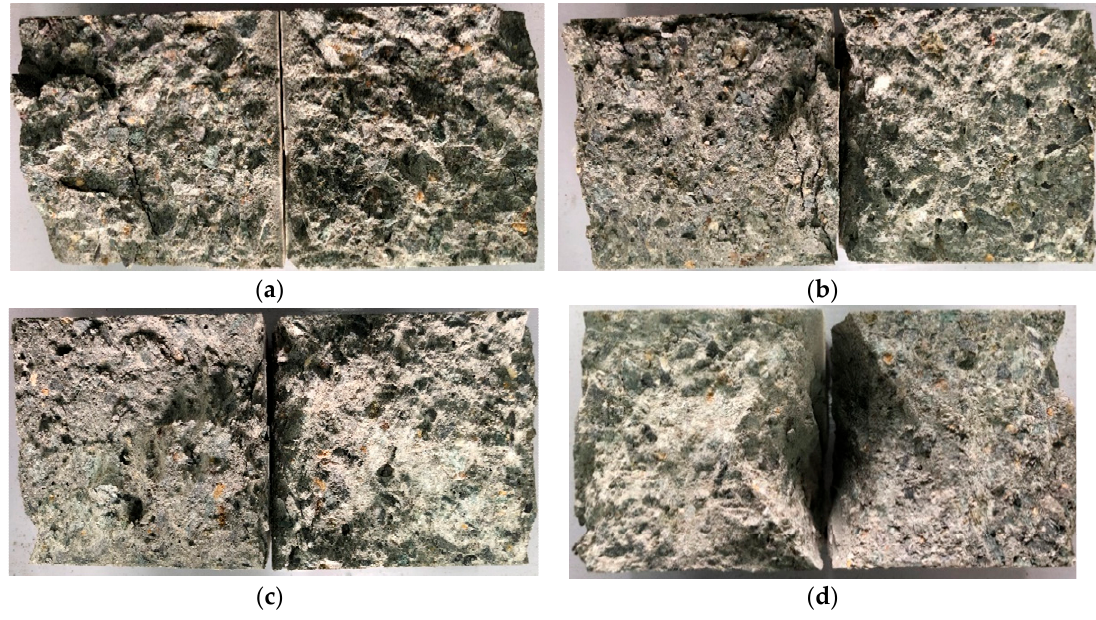
Figure 3. The internal shear failure surface of compression-shear experiments: ( a ) Shear failure surface of SCC-CS-0; ( b ) Shear failure surface of SCC-CS-2; ( c ) Shear failure surface of SCC-CS-6; ( d ) Shear failure surface of SCC-CS-10.